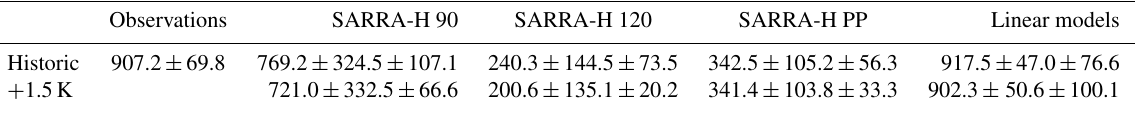
Table 5. Simulated sorghum yields (kgha − 1 ) in West Africa for observations and four crop models for the historic time period and at 1.5K. The first uncertainty value is the inter-annual variability and the second is the spread across the RCM–GCM ensemble.